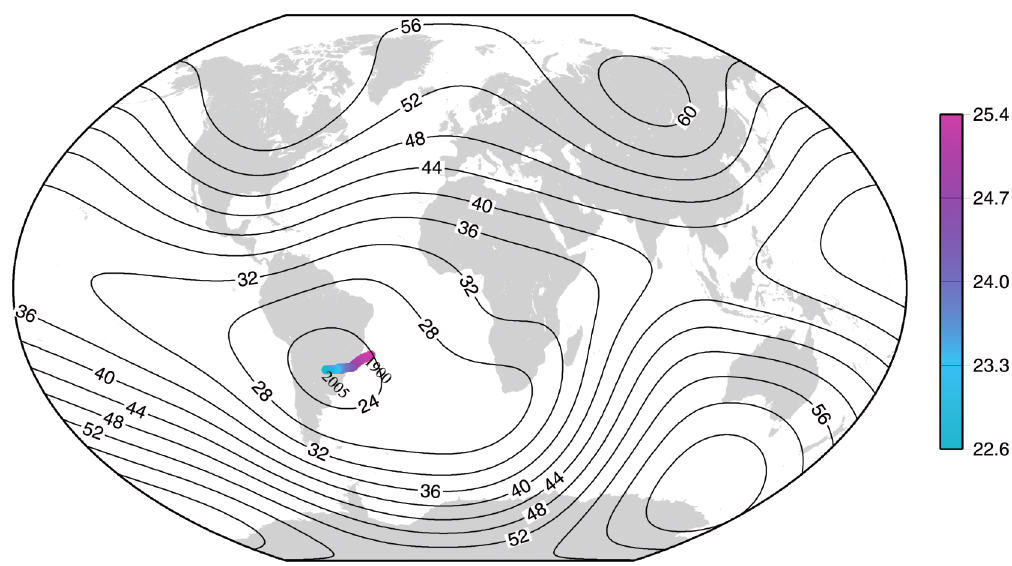
Fig. 2. Magnetic field strength ( µ T) at 2005.0 and the loci of minima from 1900 from 10th Generation Inter- national Geomagnetic Reference Field (IGRF-10) (Maus et al. , 2005).